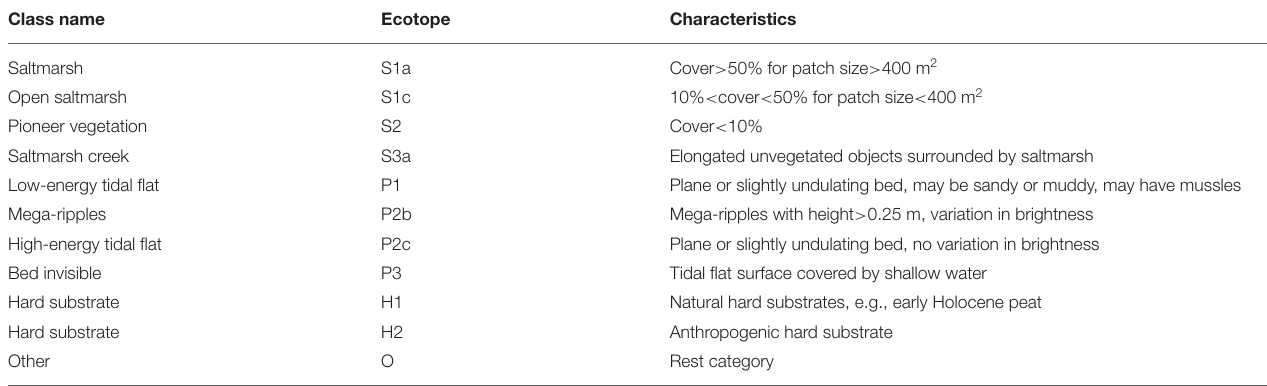
TABLE 2 | Biogeomorphological classes and characteristics of intertidal and supratidal areas in the saline